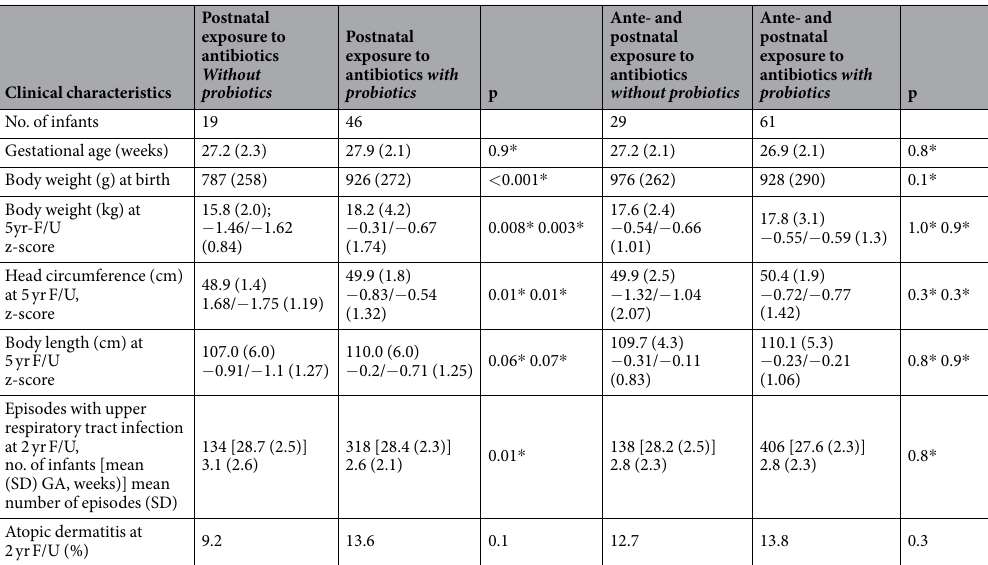
Table 7. Follow-up data of infants exposed to postnatal antibiotics according to prophylactic use of Lactobacillus acidophilus/Bifidobacterium infantis probiotics. Legend: Continuous variables are shown as mean (SD); z-scores are shown as mean/median (SD). Categorical variables are shown as percent. p-values were derived from Fisher’s exact test or Mann-Whitney-U test if indicated ( * ), SGA, small for gestational age ( < 10th percentile of birth weight adjusted to gestational age). Growth velocity and weight gain were calculated by differences between parameters at birth and respective measures at discharge/number of days (duration of